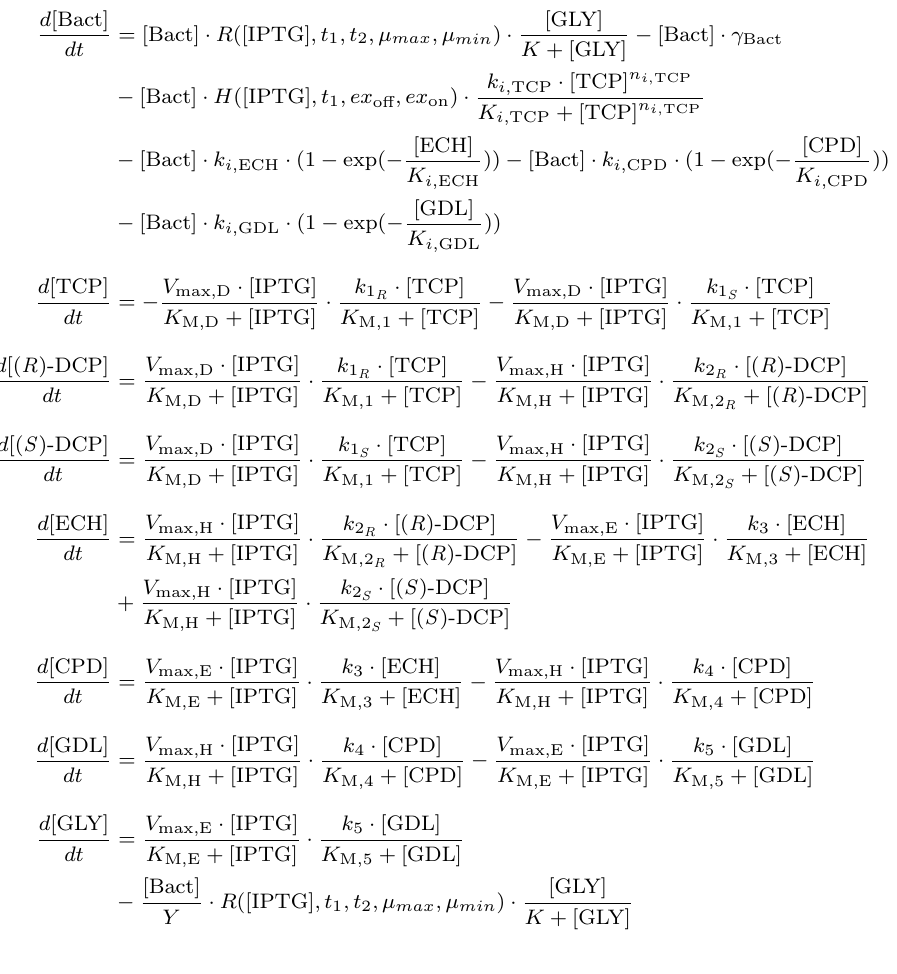
Figure 11. An ODE model of the extended TCP metabolic pathway. The model represents a chain reaction for biodegradation of TCP into GLY reflecting the E. coli population. Note that the rate constants of the original ODE model were rescaled from seconds (s − 1 ) into hours (h − 1 ) because the data used for fitting were sampled every hour. It concerns the original rate constants ( k 1 k 3 , k 4 , k 5 ). Units: k